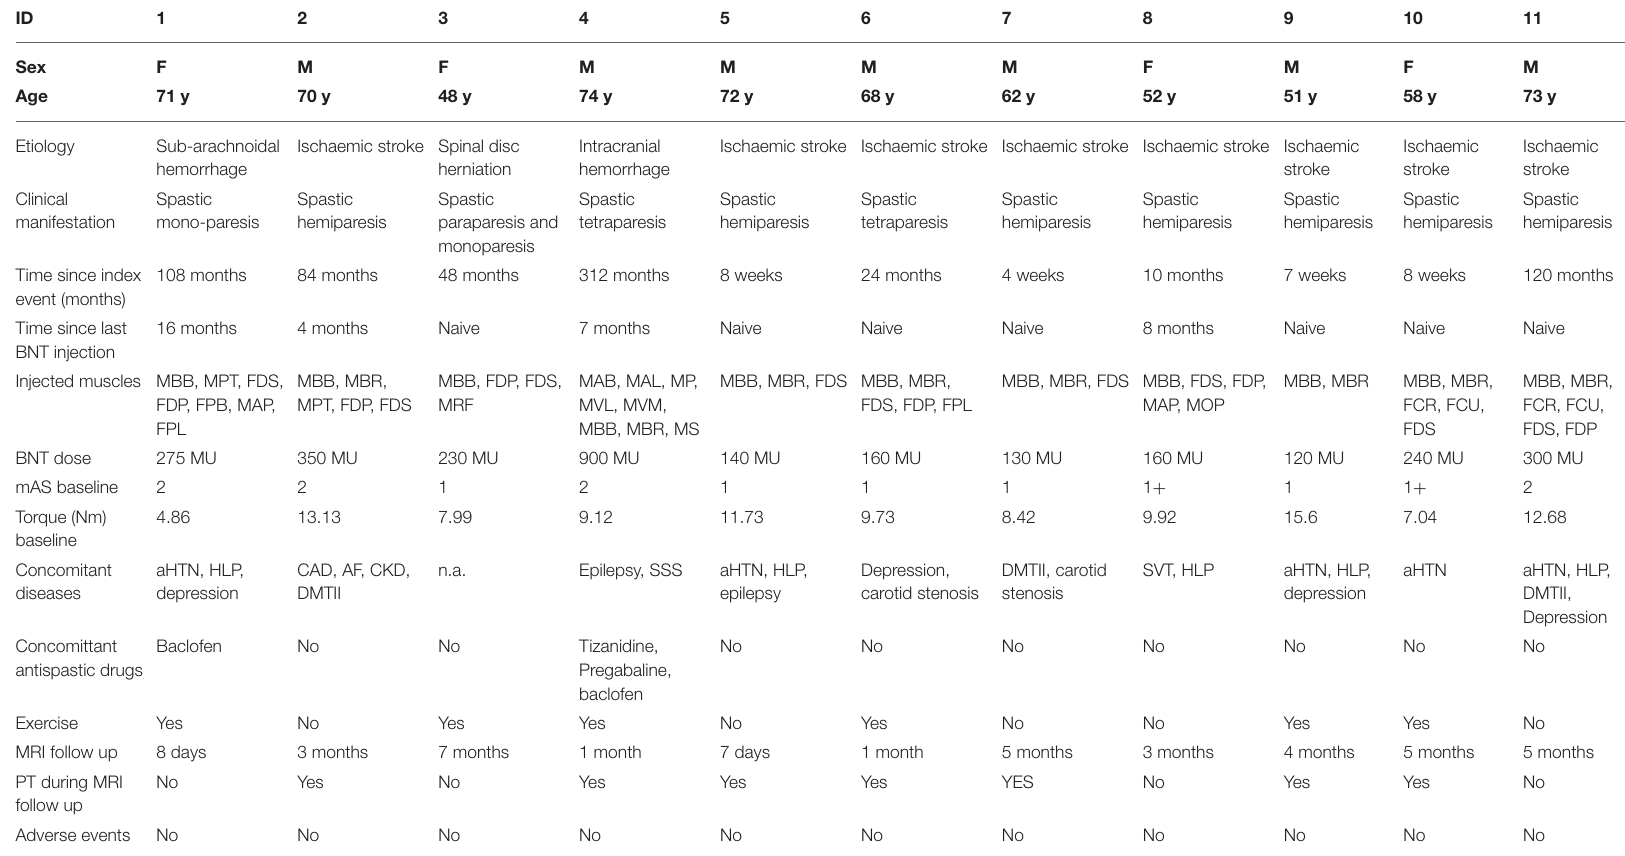
TABLE 1 | Summary of patient’s individual